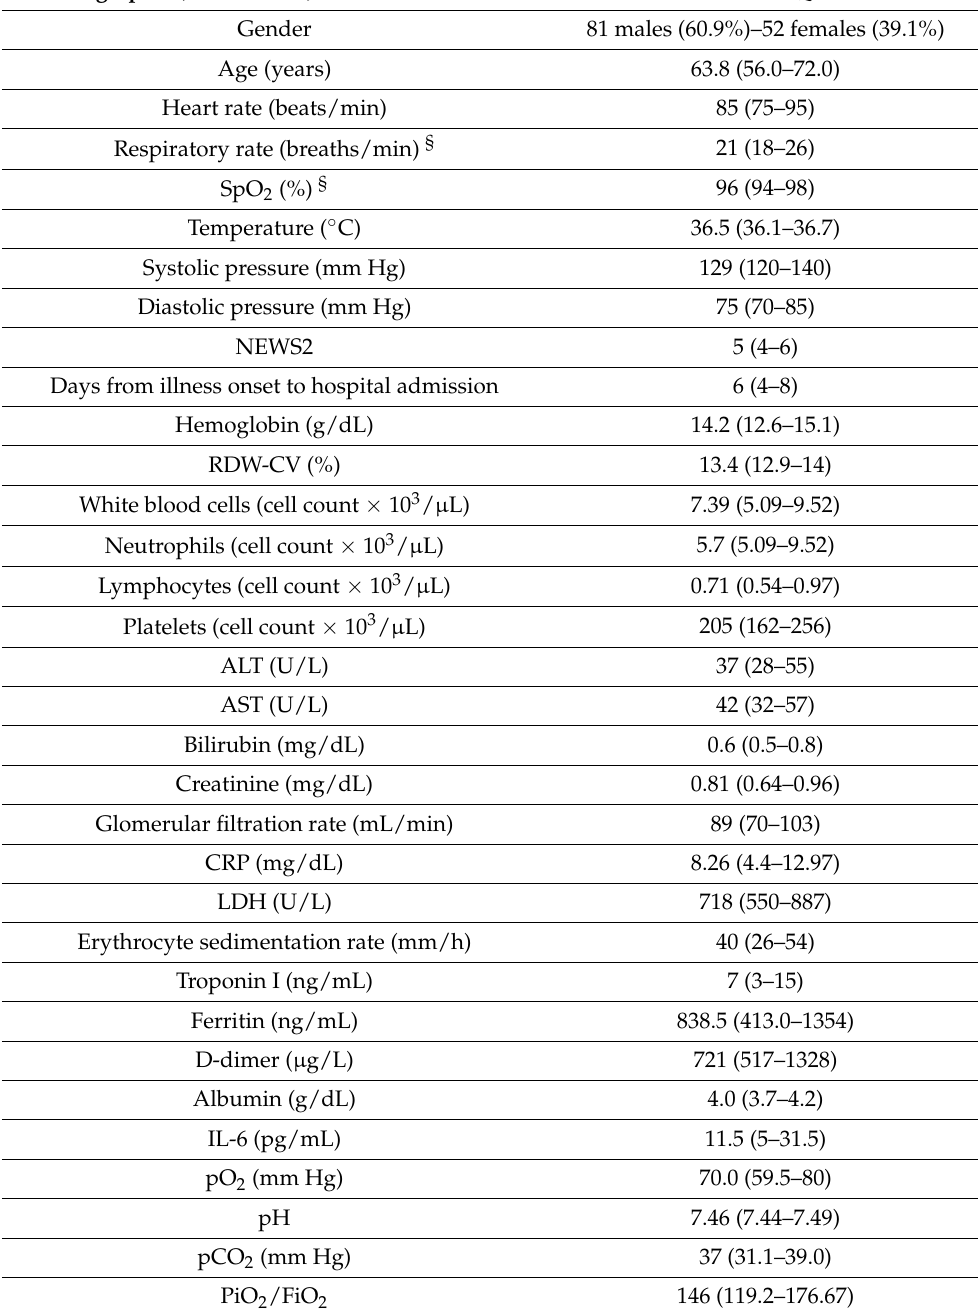
Table 1. Demographic characteristics and hospital admission (baseline, t0) clinical conditions of the patients included in this study. IQR, interquartile range. § refers to data obtained with oxygen